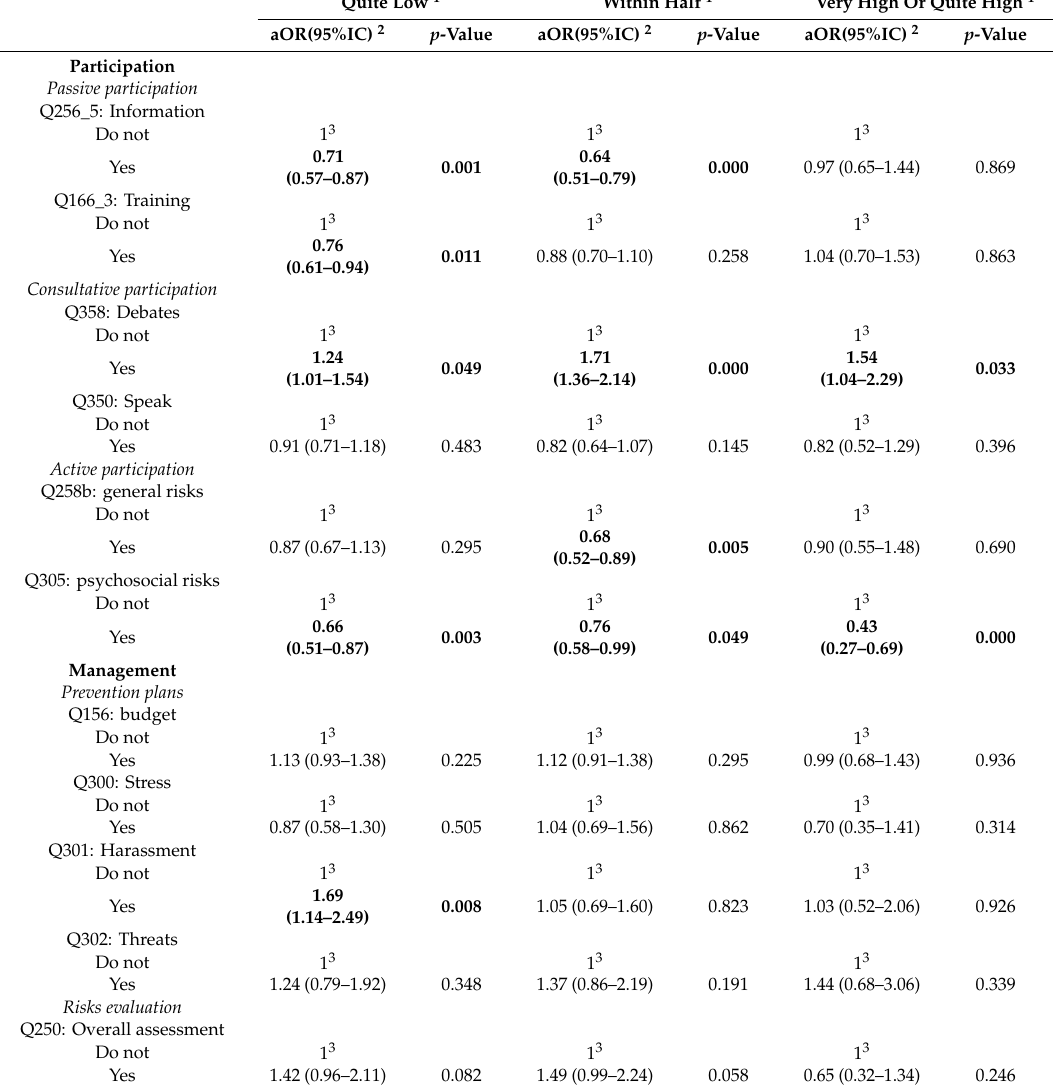
Table 2. Logistic regression multinomial for levels of absenteeism cited. Quite Low 1 Within Half